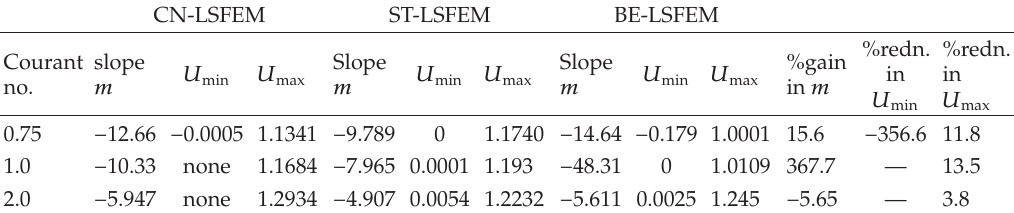
Table 2: Propagation of discontinuity by t (cid:9) 0 .